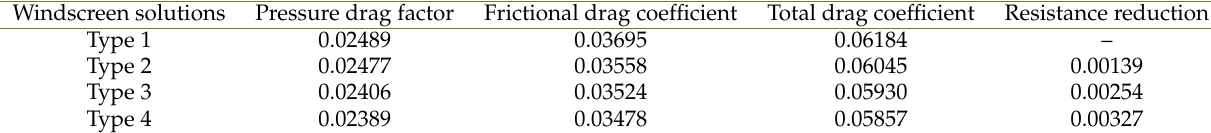
Table 5. Comparison of tail car drag coefficients.